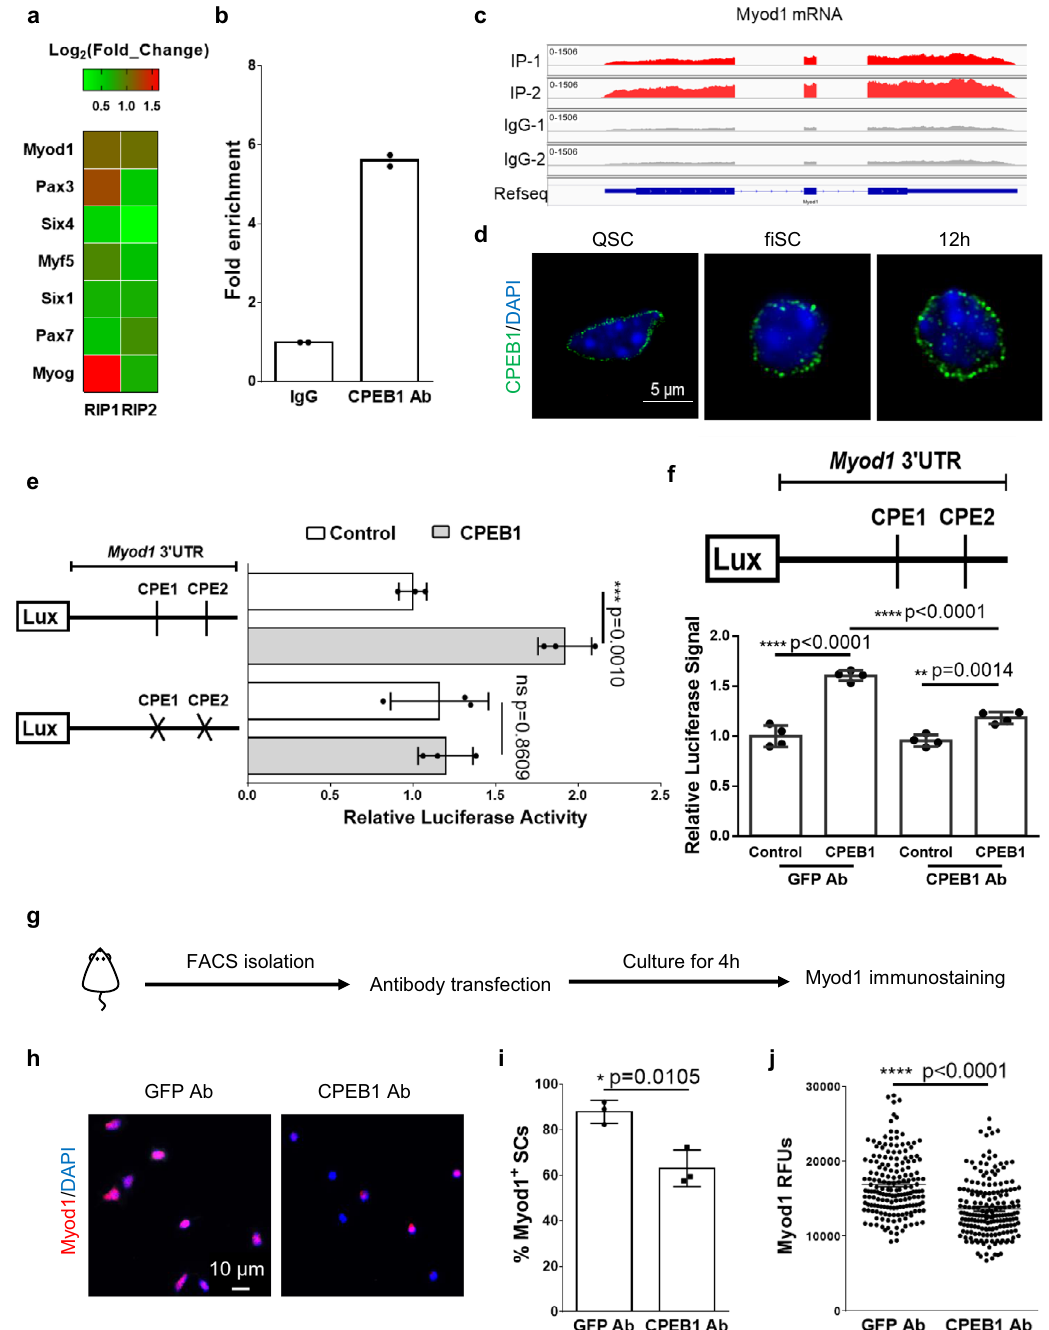
Fig. 5 CPEB1 regulates Myod1 protein output by acting on the CPEs within its 3 ’ UTR. a – c a Heatmap of the Log 2 (Fold_Change) of muscle factors in the CPEB1 RIP-Seq analysis. b Real-time PCR (qRT-PCR) analysis of Myod1 mRNA after CPEB1 RNA-IP on fi SCs. ( n = 2 independent experiments). c CPEB1 RIP-seq data of Myod1 transcripts. d CPEB1 immunostaining on QSCs, fi SCs and 4hour cultured SCs (12hours after mice were sacri fi ced). Nuclei were stained with